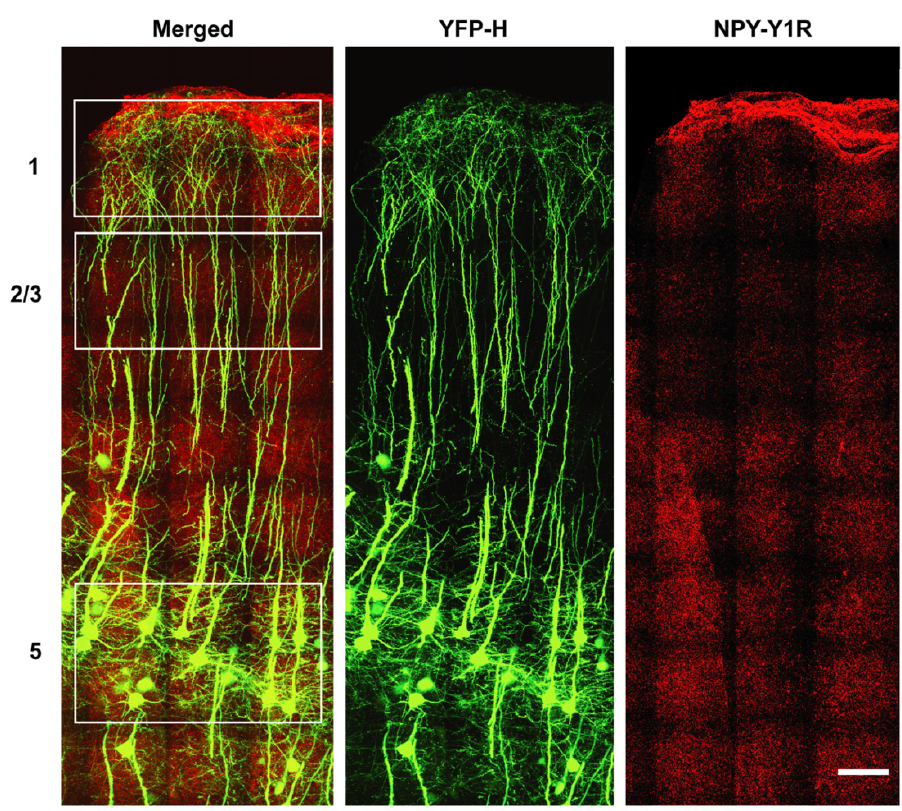
Figure 4. Representative immunohistochemistry of NPY-Y1 receptors (red) and YFP-H-positive upper motor neurons (green) obtained from a YFP-H mouse at 20 weeks of age. White boxes indicate regions selected for quantitative analysis of NPY-Y1 receptor expression on YFP-H upper motor neurons. Nissl stain was also utilized for lamina localization. Scale bar = 200 µm.